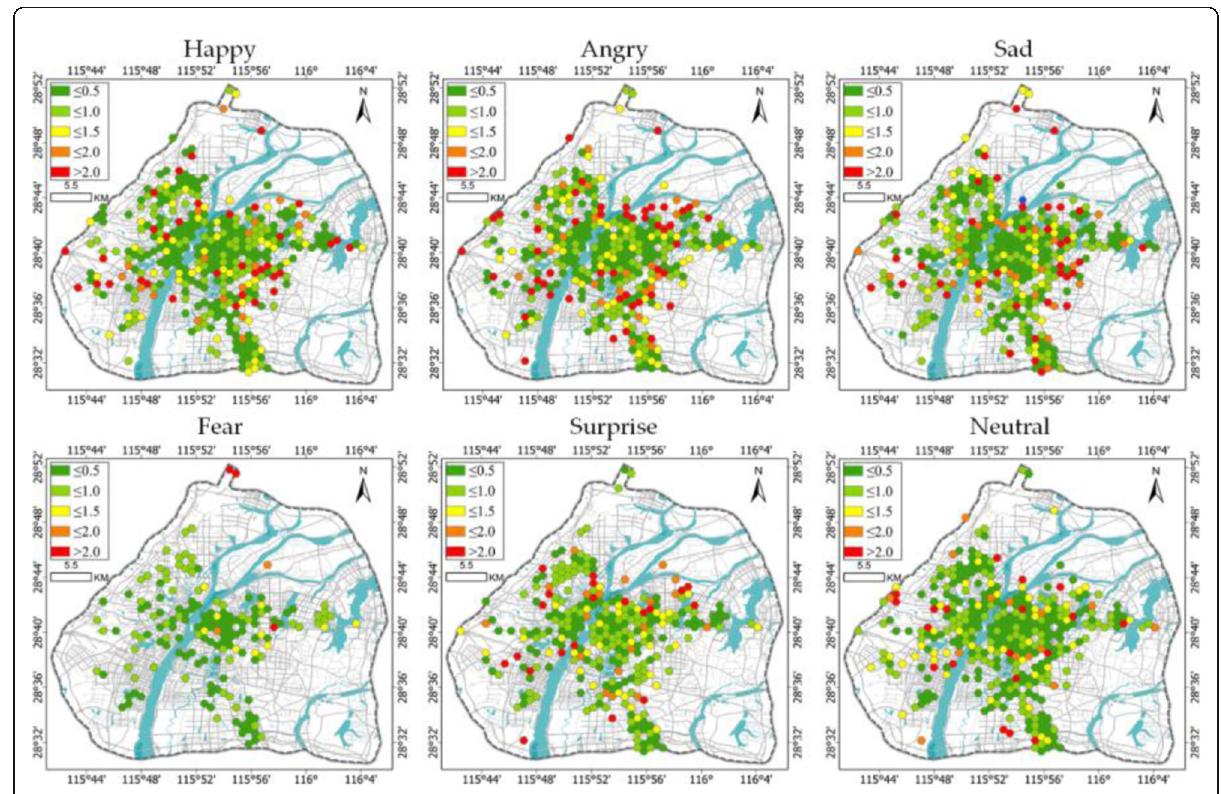
Fig. 9 The spatial pattern of the LISA of the emotions from day to